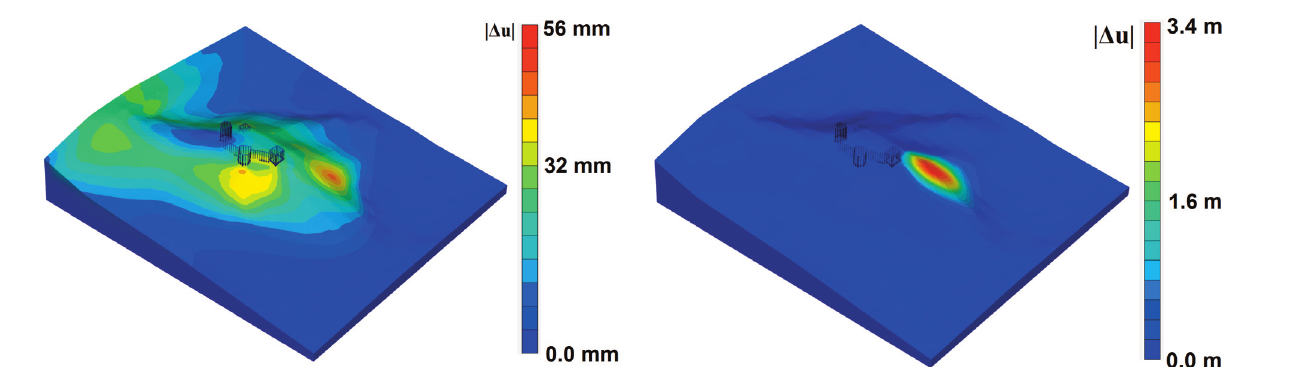
Fig. 6. Modelled plastic deformations of colluvial material visualized through shadings of the total displacement increments (| Δ u|).